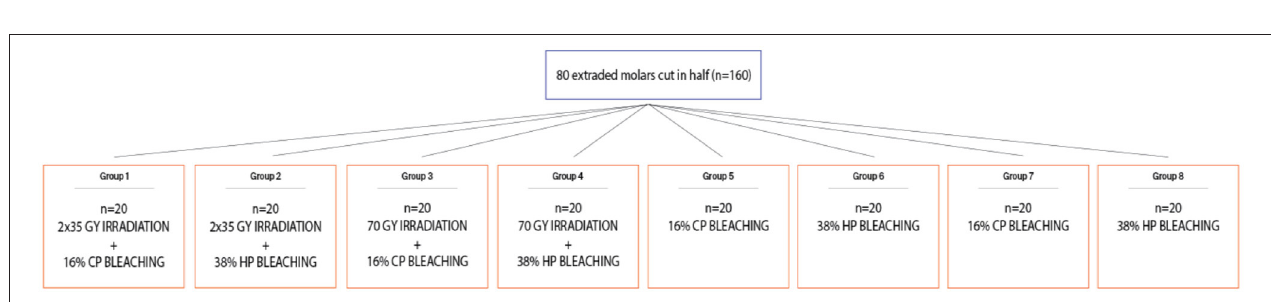
FIGURE 2 | Flowchart of the groups used in the study. treatment. Measurements were carried out using the Vickers microhardness test (ESI Prüftechnik GmbH, Germany) with a force of 100 g for 10 s (27, 28). A diamond pyramid applied to the sample surface was used for measurement. Vickers measurements (HV) were performed at three different